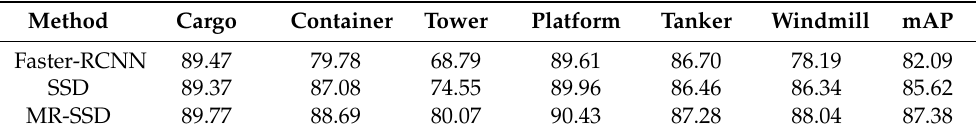
Table 7. Compositions of the large-scale SAR image. 448